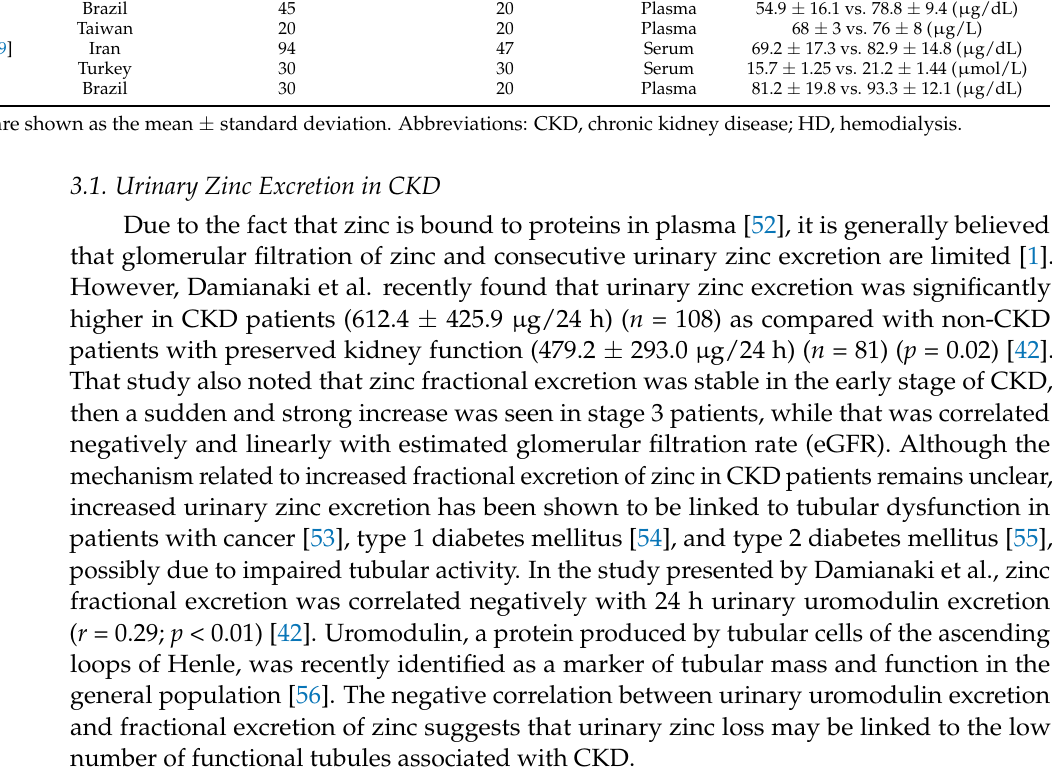
† Zinc level values are shown as the mean ± standard deviation. Abbreviations: CKD, chronic kidney disease; HD,